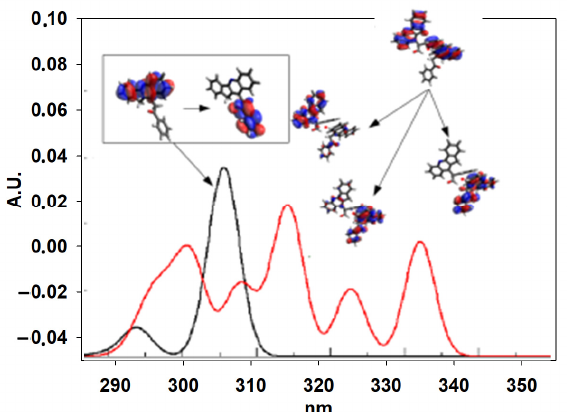
Figure 3. Comparison between the spectra of the monomer (black) and the dimer (red) of quinoline 3 . The first three transitions for the dimer have been identified (from right to left) as H → L, H → L + 1, and H → L + 2, respectively. Intensities correspond to oscillator strengths and must be considered as reported in arbitrary units.